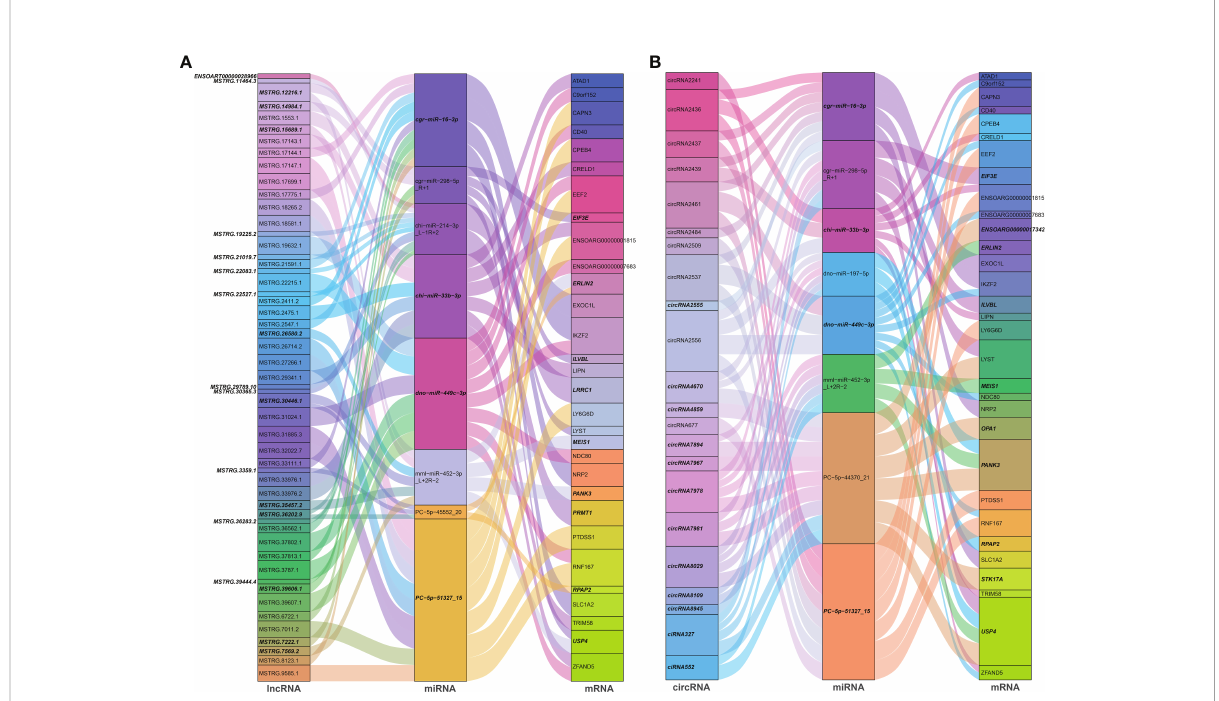
FIGURE 6 Sankey diagrams of ceRNA network based on (A) lncRNA-miRNA-mRNA, and (B) circRNA-miRNA-mRNA interaction pairs. Different colored blocks represented different dif-RNA nodes, and the downregulated dif-RNAs were indicated with bold italic font. The fl ow charts from dif- lncRNAs or dif-circRNAs to dif-miRNAs, and fi nally to dif-mRNAs represented lncRNAs or circRNAs regulated the expression of mRNAs through different